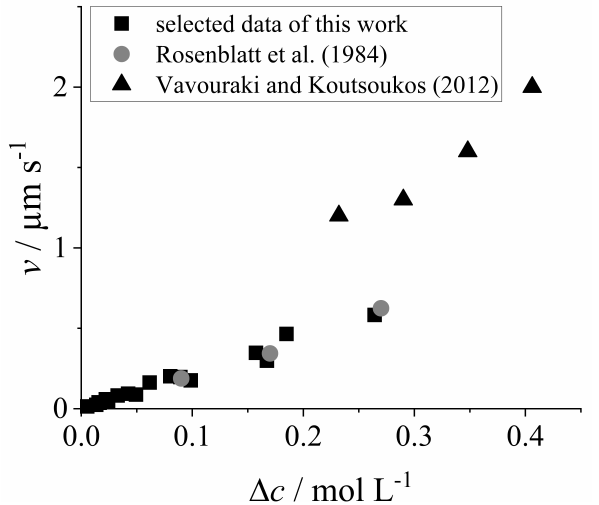
Figure 7. Growth rates v of sodium sulfate decahydrate as a function of ∆ c = ( c of data from the present work (black squares) with data from the literature: Rosenblatt et al. [48] (gray circles) and Vavouraki and Koutsoukos [49] (black